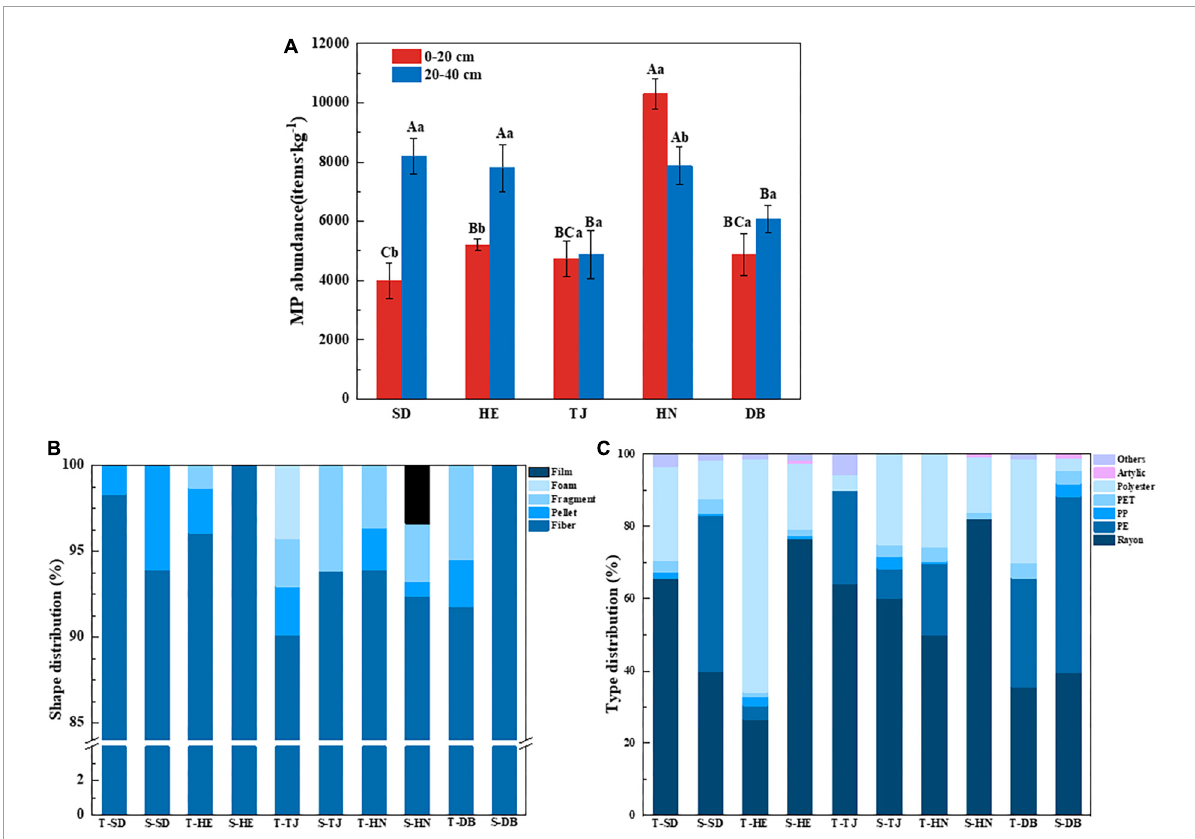
FIGURE3 Microplastic (MP) abundance in different paddy soils (A) ; percentage of MP shape distribution (B) and compositions (C) of paddy soils among different geographic positions. T-: 0–20 cm layer; S-: 20–40 cm layer. Different capital letters indicate the significant difference among different geographic positions, and different lowercase letters indicate the significant differences between soil depths ( P < 0.05) ( n =